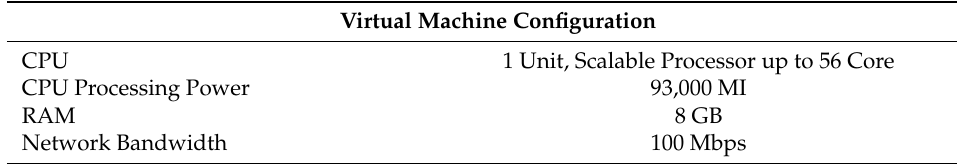
Table 3. Base Configuration of Virtual